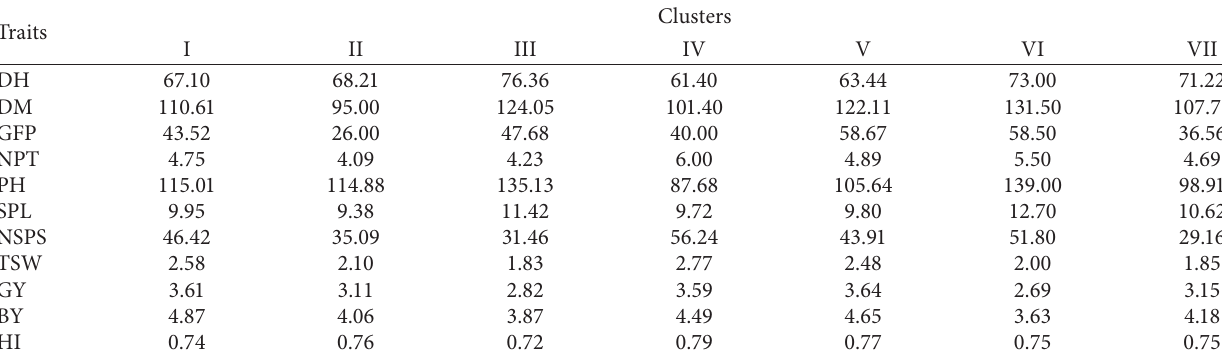
Figure 1: Principal component’s biplot of all studied traits of bread wheat germplasm. DH: days to heading, DM: days to maturity, GFP: grain filling period, PH: plant height, NSPS: number of seeds per spike, and dot symbol � accession code. Table 5: Cluster mean values for eleven traits in bread wheat accessions.